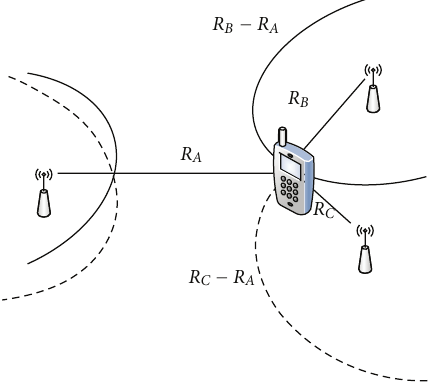
Figure 2: Representation of ToA localization technique.